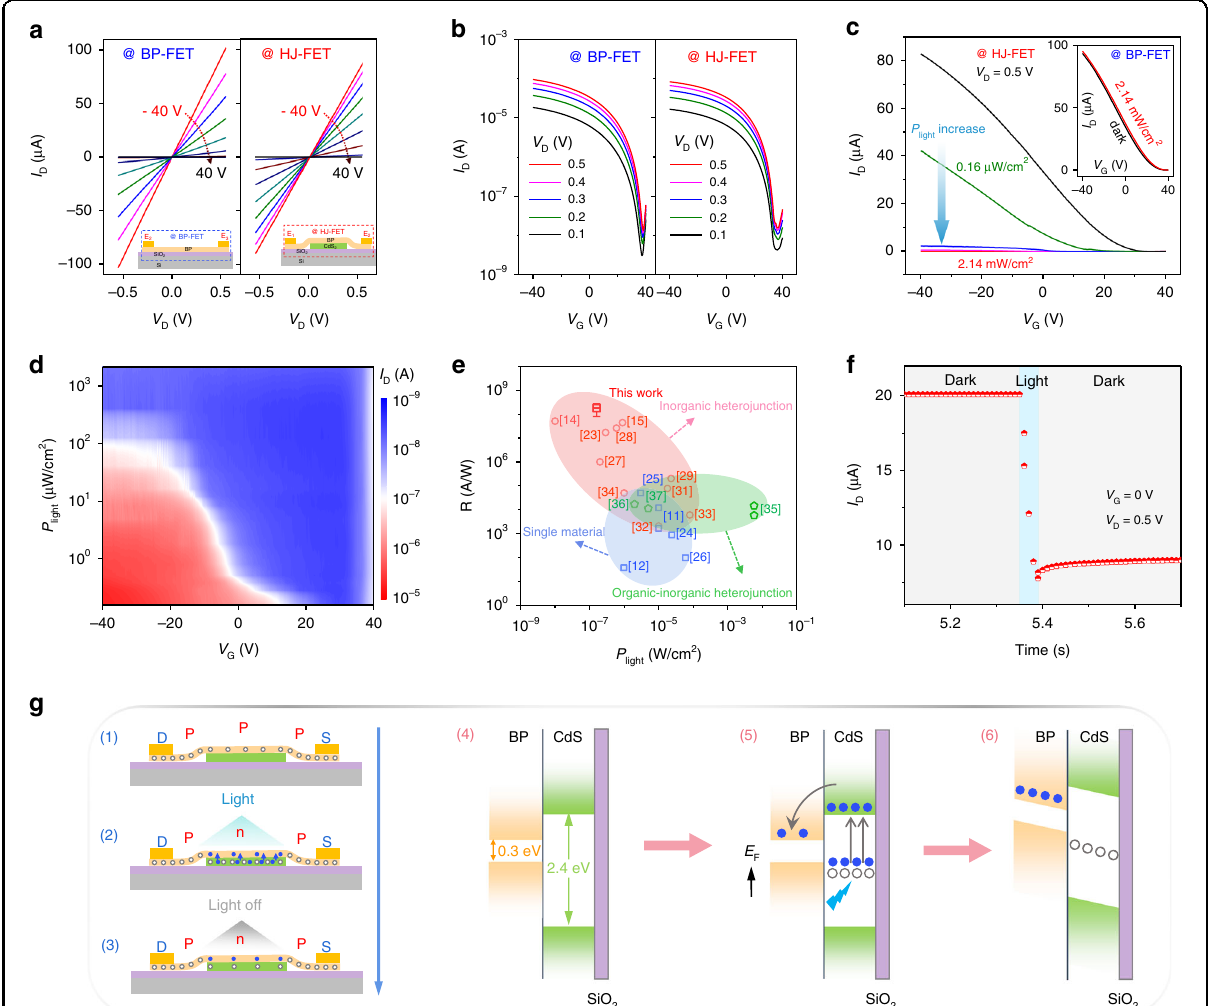
Fig. 2 Optoelectronic characteristics of the designed device and corresponding working mechanism. a The output characteristics of HJ-FET and BP-FET at various back gate voltage under dark condition. Inset: the front diagram of vdWs optoelectronic synaptic device, device between electrodes E 1 and E 2 is named as heterojunction FET (HJ-FET), device between electrodes E 2 and E 3 is named as normal BP FET (BP-FET). b The transfer curves of HJ-FET and BP-FET at different V D under dark condition, both showing a strong p-type and weak n-type behavior. c The transfer curves of HJ-FET in dark condition and different light power illumination. V D is fi xed at 0.5 V, showing an obvious negative photoresponse. d 2D plot of I D as a function of light power intensity ( P light ) and V G . e R summary of photoelectronic device based on single and hybrid materials, demonstrating an ultra- high responsivity among reported devices. f Photoresponse current of the arti fi cial synapse at P light = 11.97 μ W cm − 2 and V G = 0 V with light pulse width at 50 ms. g Charge-trapping state and corresponding energy band diagram of the HJ-FET in dark condition (g 1 and g 4 ), under light illumination (g 2 and g 5 ) and after removing light source (g 3 and g 6 ). E F : Fermi